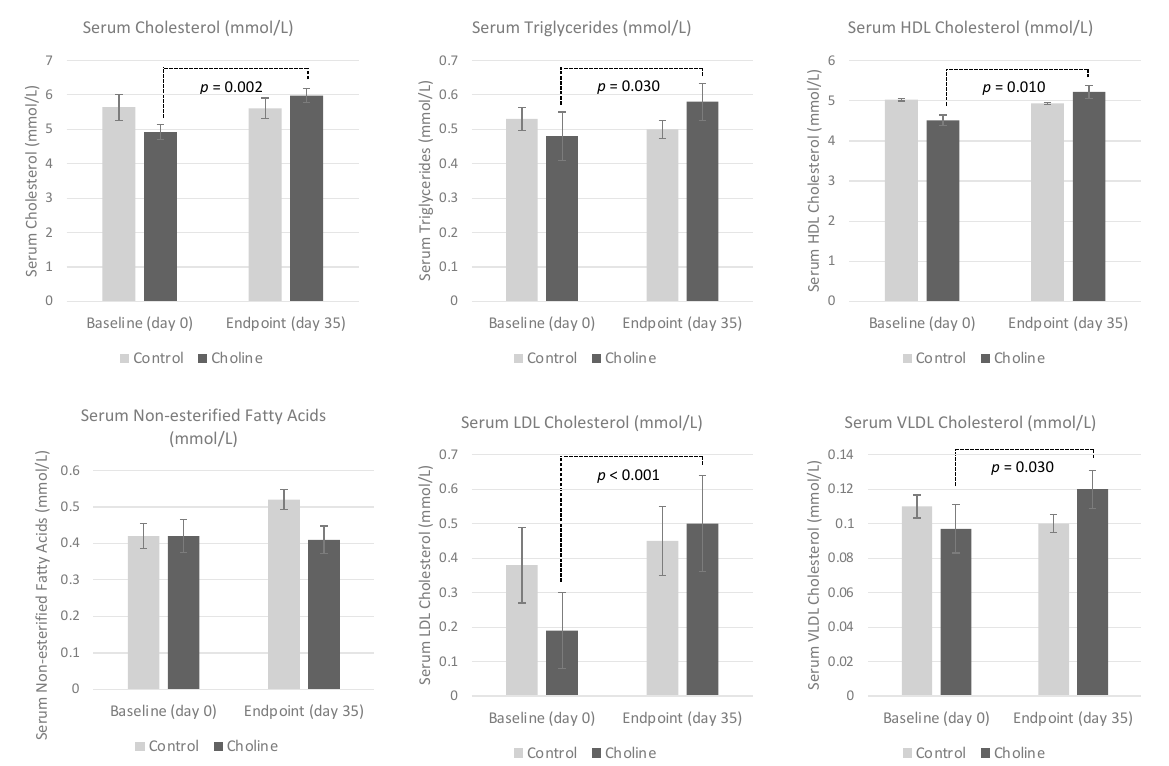
Figure 1. Serum lipoprotein concentrations (mmol/L) in 12 chronically obese cats following 5 weeks of a control extruded cat food (458.7 mg choline/100 g dry matter (DM)) ( n = 6) or a high-choline extruded cat food (1895.7 mg choline/100 g DM) ( n = 6). Both groups were fed at maintenance energy requirements. Values are expressed as the mean ± SEM.